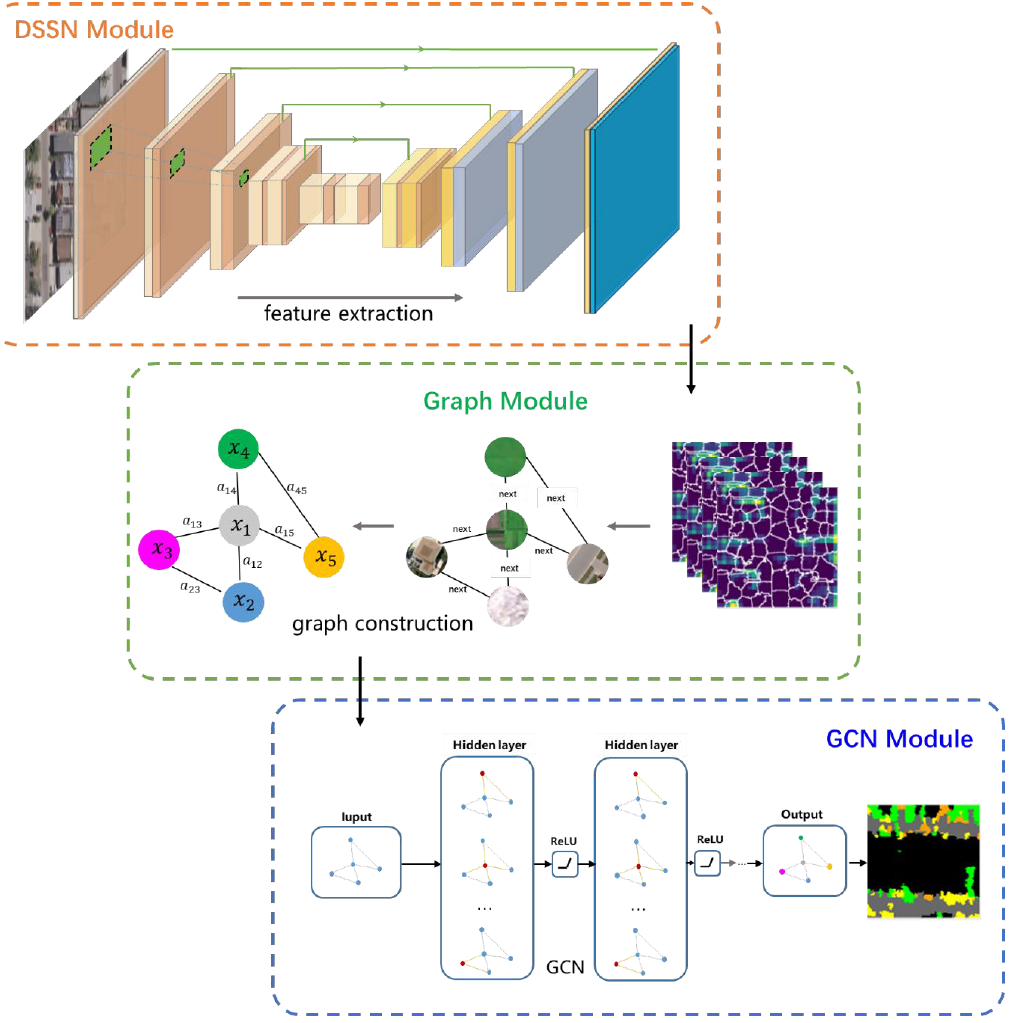
Figure 1. The workflow of the proposed deep semantic segmentation network (DSSN)-graph convolutional neural network (GCN) framework, including the DSSN module, the graph module and the GCN module. The whole process goes from top to bottom. First, the DSSN module extracts the deep features for the semantic initialization of the graph nodes. Then the graph module constructs the graph with ground objects and their spatial relationships. Finally, the GCN module combines the features and the spatial relationships in the graph to perform classification.